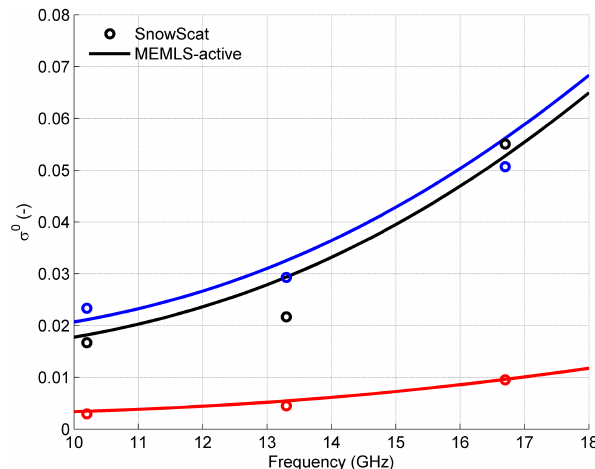
Figure 6. σ 0 measured by SnowScat (circles) and modeled by MEMLS3&a (lines) with SMP (solid), CT (dashed) and NIP (dot- ted) inputs. MEMLS3&a runs are performed with the snow–ground reflectivity s 0 calculated by Wegmüller and Mätzler (1999), and s s0,h = 0.75 s 0,h , s s0,v = 0.75 s 0,v . The mean slope of the surface undulation was set to m = 0 . 1 and the cross-polarization ratio to q = 0 . 15. Colors represent polarization, with vv – black, hh – blue and hv – red.